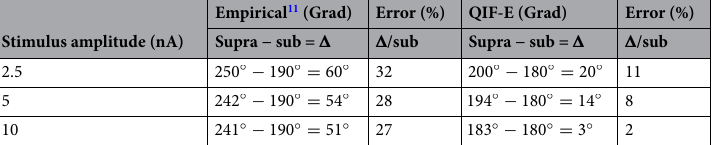
(Table 2) and phase preference (Table 3)- –between the results of the two regimes: sub- and supra-thresholds, respectively, for both analysis: QIF-E model and empirical outcomes. Thus, increasing the current amplitude shows a decrease in the difference between these two results, decreasing the error between them. The QIF-E model obtained a result of this behavior (increase in amplitude decrease in relative error) similar to that found in the empirical study.